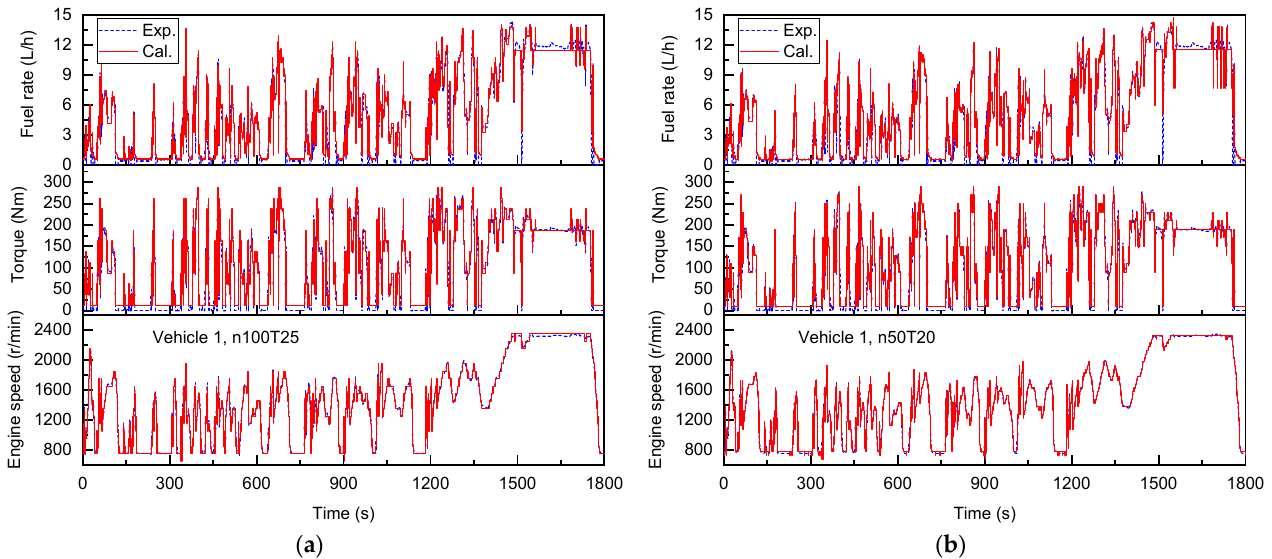
Figure 5. Reconstruction of the chassis dynamometer cycle (vehicle one). ( a ) n100T25. ( b ) n50T20.